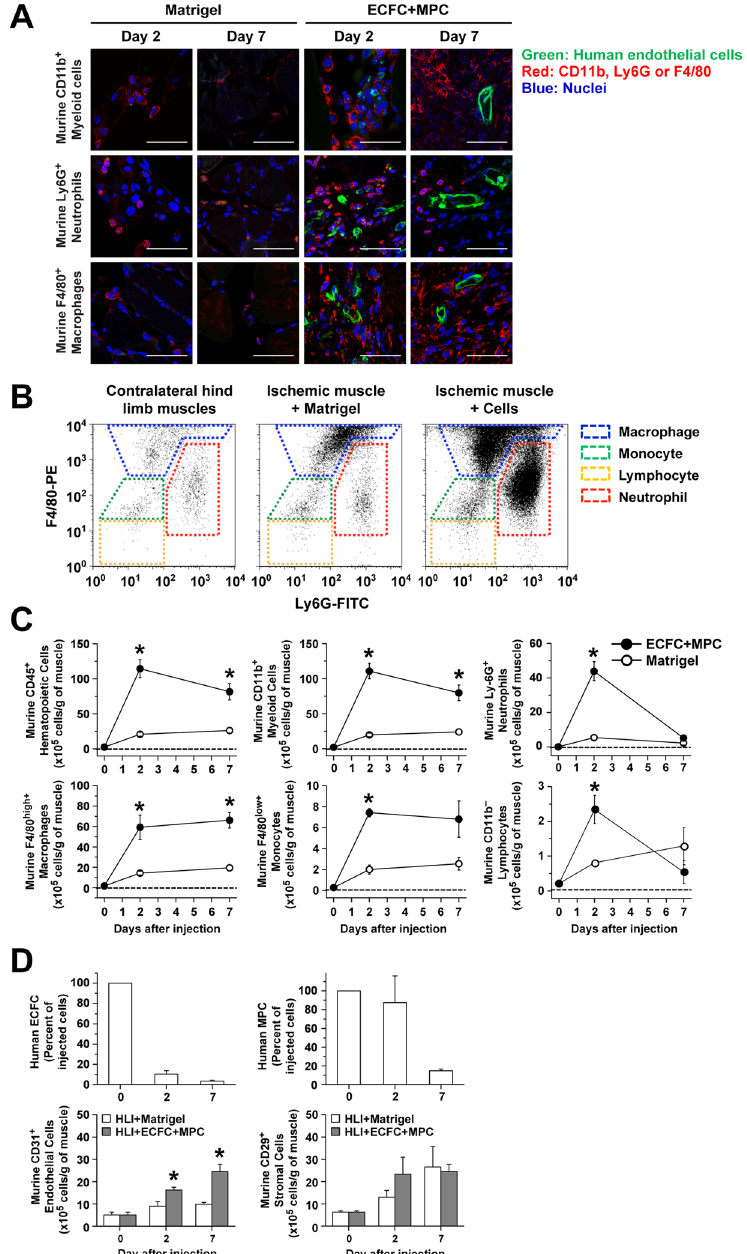
Figure 2. Myeloid cells recruited into murine ischemic hind limb muscle after human ECFC + MPC injection. Ischemic hind limb muscles with/without cell injection were harvested, fixed, and sectioned for confocal microscopy analysis. Sections were incubated with biotinylated UEA I followed by Fluorescein-Streptavidin to detect human ECFC (green). After that, sections were incubated with primary antibodies (rat anti-mouse CD11b, rat anti-mouse Ly-6G, or rat anti-mouse F4/80 antibodies) followed by goat anti-rat Alexa Fluor- 568 (red). In parallel experimental sets, ischemic hind limb muscles were harvested, digested and analyzed by flow cytometry. ( A ) Representative confocal images of myeloid cells in the ischemic hind limb muscles injected with Matrigel or ECFC + MPC at day 2 and 7 (scale bars represent 50 μ m). ( B ) Representative flow cytometry analyses of contralateral hind limb muscles and ischemic hind limb muscles injected with Matrigel or ECFC + MPC at day 2. ( C ) Quantitative cytometric analyses of myeloid lineage cells obtained from ischemic hind limb muscles (n = 3; means ± SEM). ○ Shows cell number obtained from ischemic hind limb muscles injected with Matrigel alone. ● Shows cell number obtained from ischemic hind limb muscles injected with ECFC + MPC in Matrigel. * Significant difference (P ≤ 0.05) between groups. ( D ) Quantitative cytometric analyses of human and murine vascular cells and murine stromal cells obtained from ischemic hind limb muscles at day 0, 2, and 7 (n = 3; means ± SEM). * Significant difference (P ≤ 0.05) between